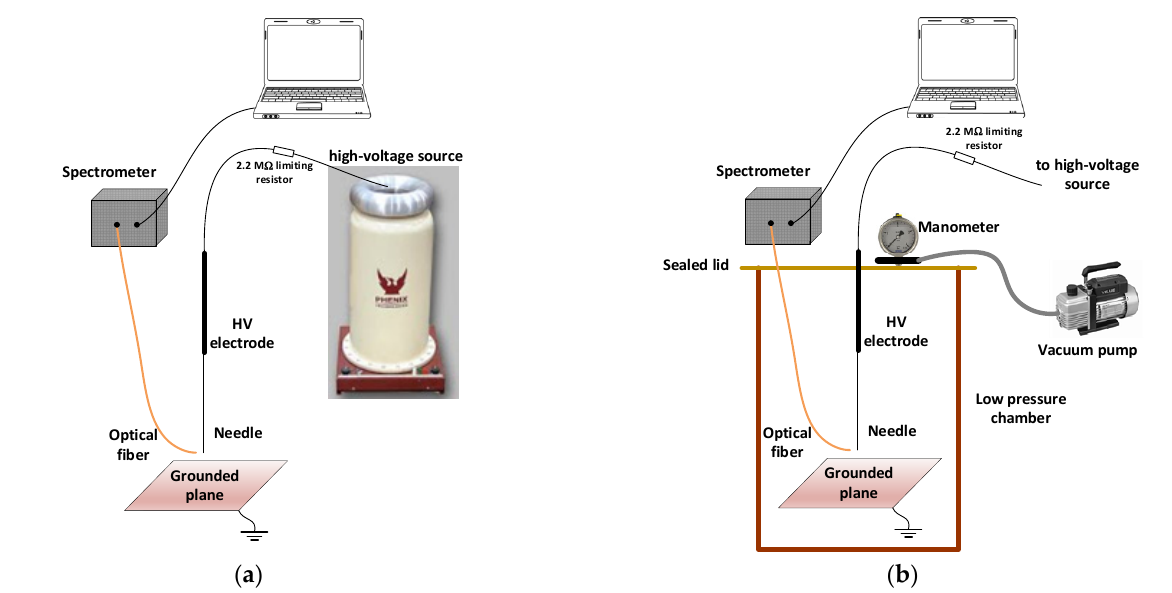
Figure 2. ( a ) Needle-plane gap in the high-voltage laboratory; and ( b ) needle-plane gap in the low pressure chamber.